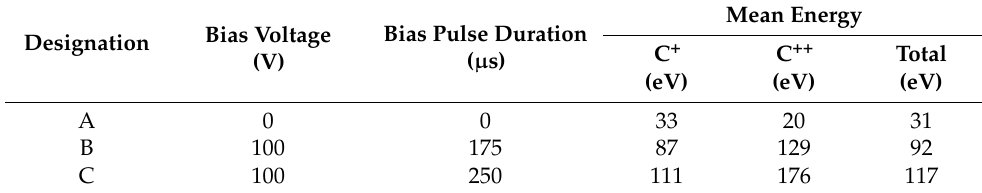
Table 3. Mean energy of the carbon ions for coatings A, B, and C.